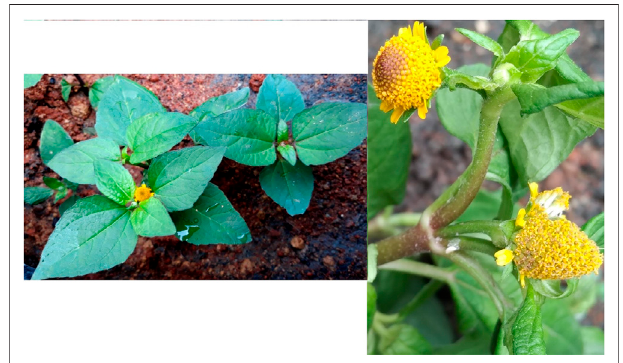
FIGURE 1 | Image of Blainvillea acmella (L.) Philipson [Asteraceae] plant with yellow fl